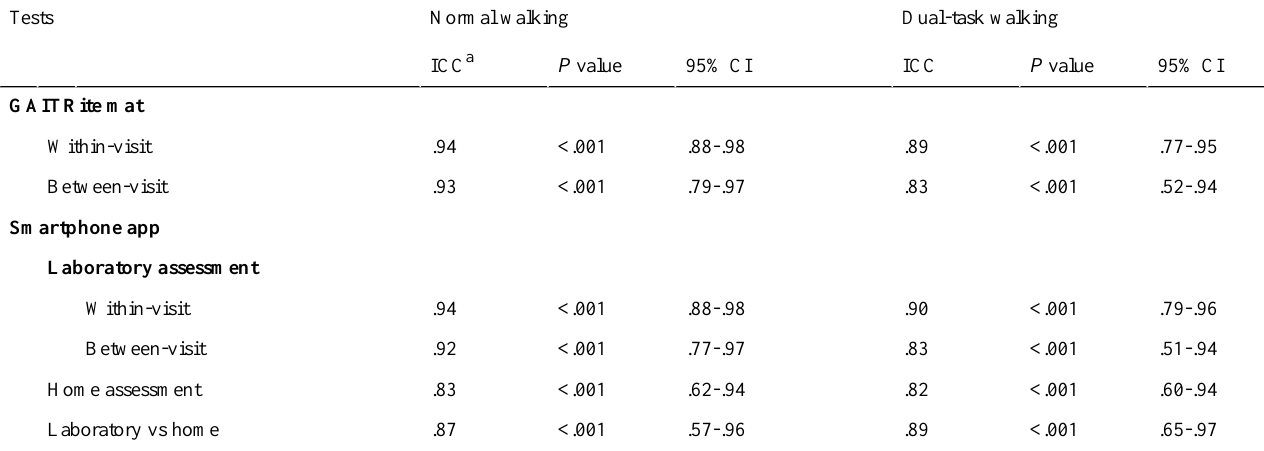
Table 1. Test-retest reliability of laboratory- and home-based assessments of average stride times during normal and dual-task